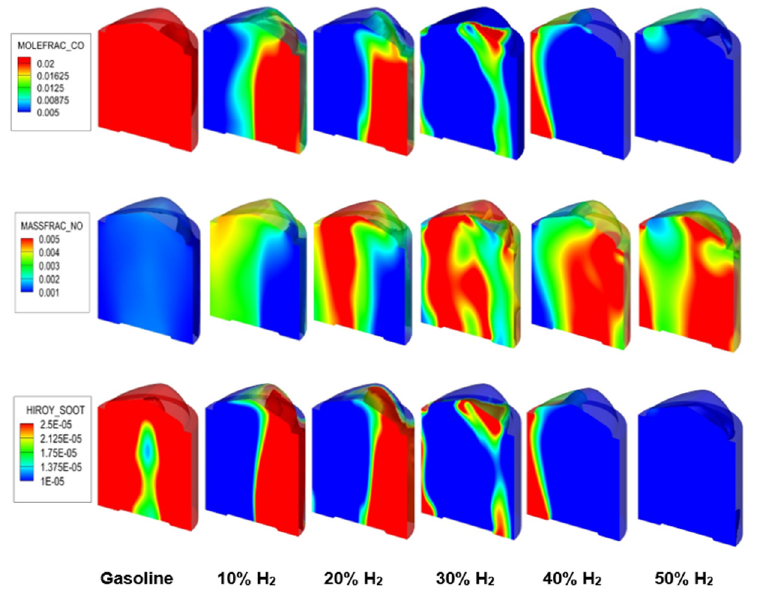
Figure 15. Effects of HES on CO, NO X and PM emissions for start of injection (SOI) − 120 CAD aTDC at exhaust valve open (EVO). at exhaust valve open